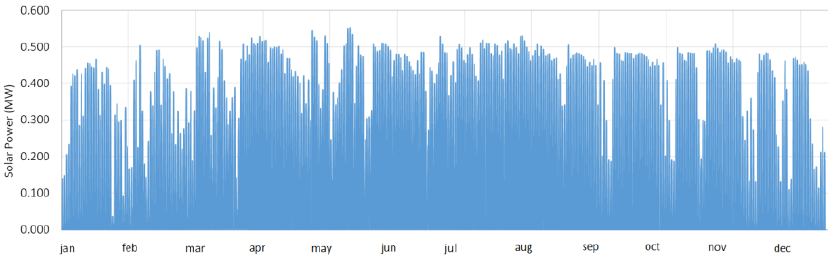
Figure 4. Average solar power distribution during an average year [28].